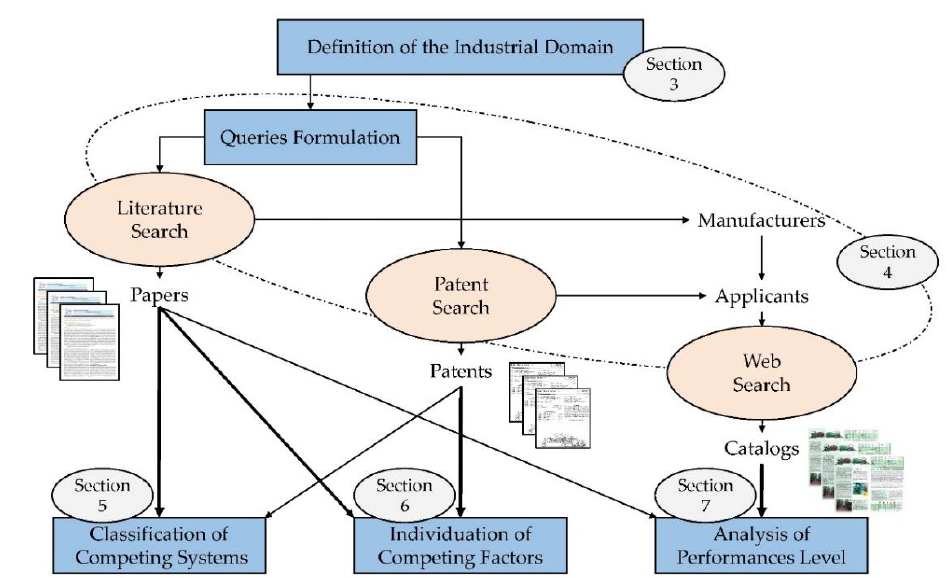
Figure 2. Structure of the information search performed in the present paper to allow for the building of value curves.